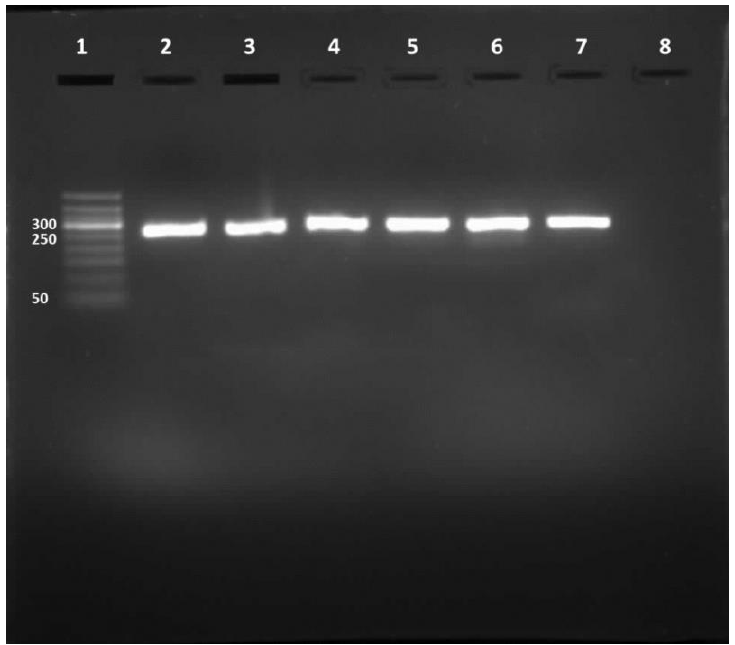
Figure 1. RT-PCR product. Lane 1, DNA ladder (50 – 500 bp). Lane 2, HAdV positive control. Lanes 3 to 7, 261-bp HAdV amplicons. Lane 8, negative control. Table 1. HAdV cases in different sample